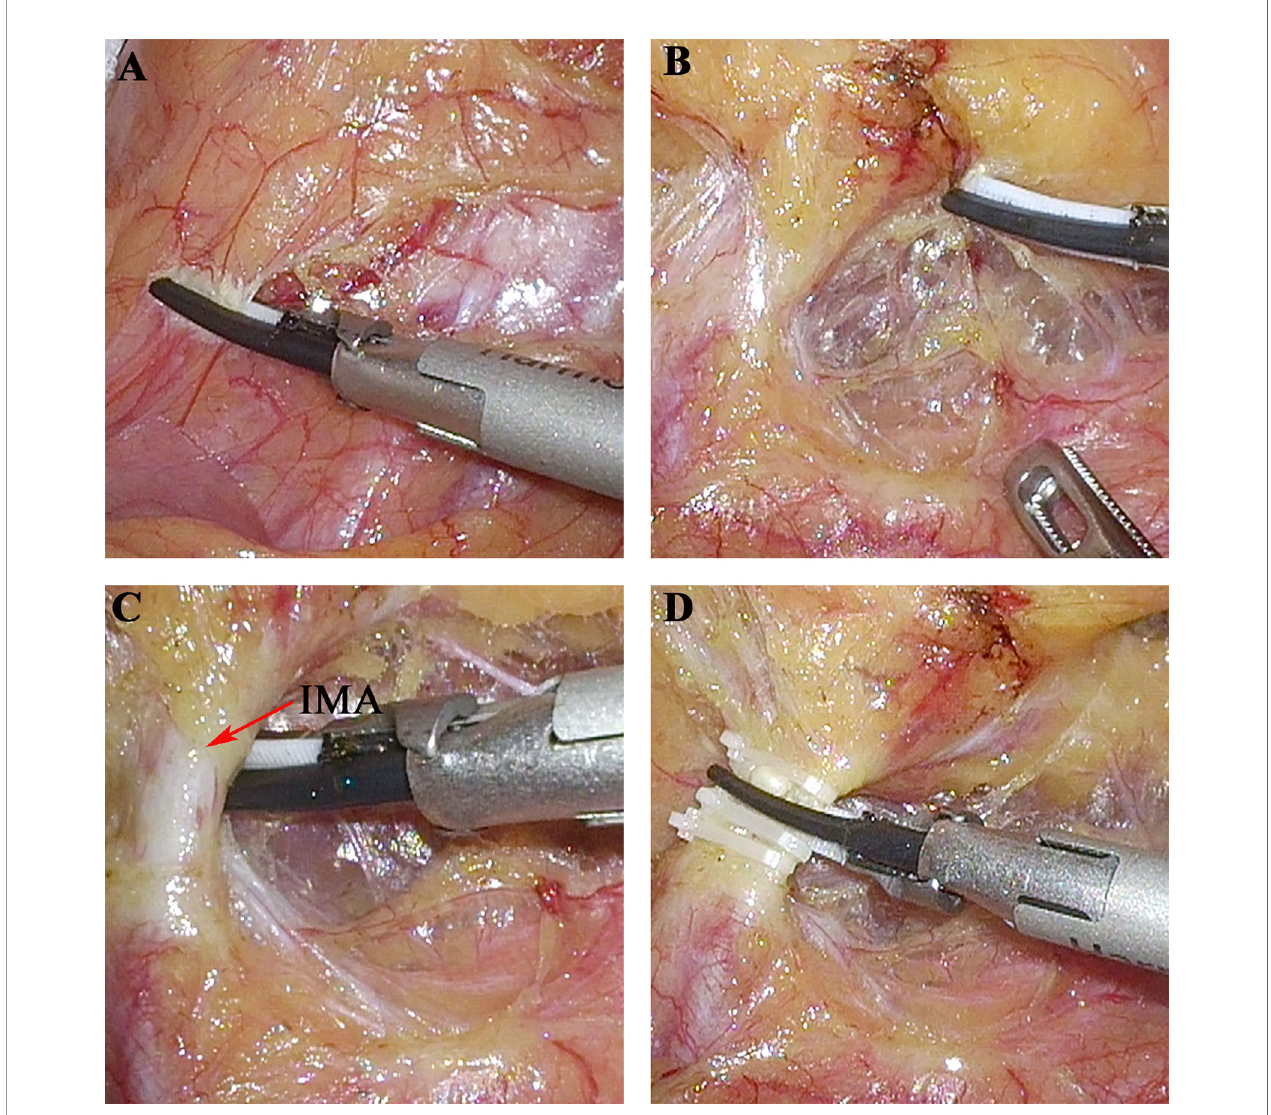
FIGURE 4 | The nerve-sparing technique of nerve plane-oriented. (A) The dissection extended up to the lower edge of the duodenum. (B) Extension from the superior hypogastric plexus nerve plane to the IMP nerve plane posterior to the IMA. (C) Abdominal aortic plexus nerve plane was gradually entered from cephalic to caudal by the “ slope downhill ” approach. (D) The IMA was ligated and cut above the IMP nerve plane. IMA, inferior mesenteric artery; IMP, inferior mesenteric